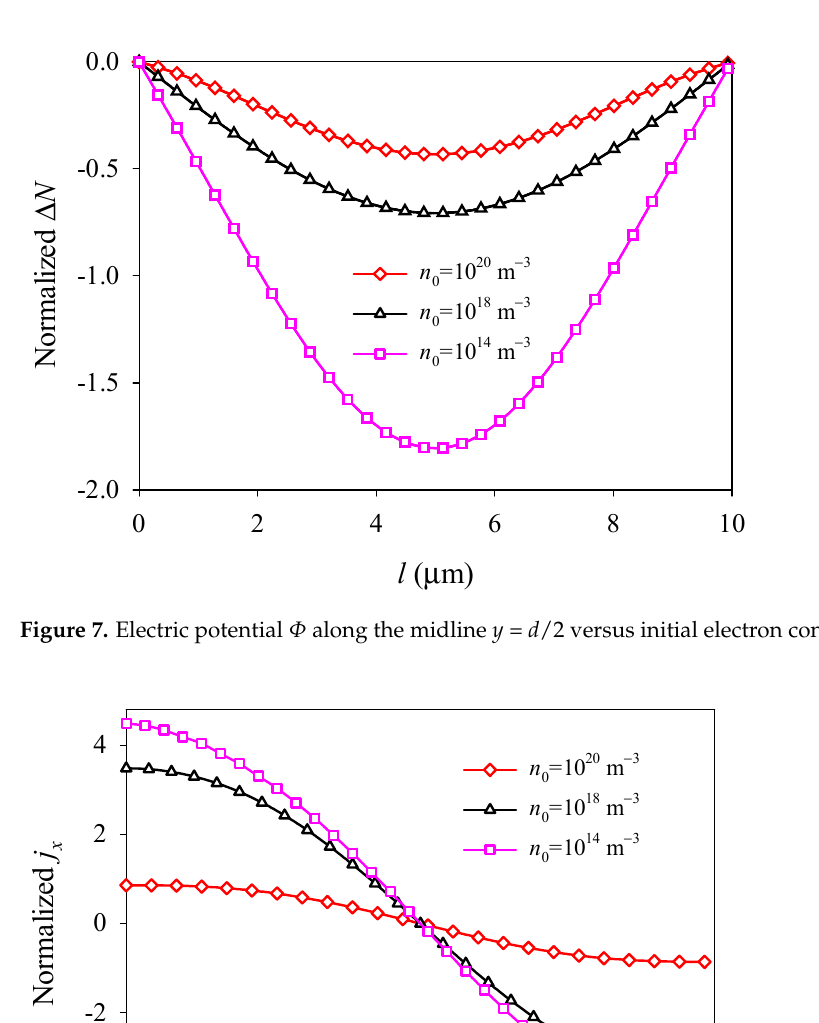
Figure 9. Electric field E x along the midline y = d/ 2 versus the initial electron concentration n 0 .